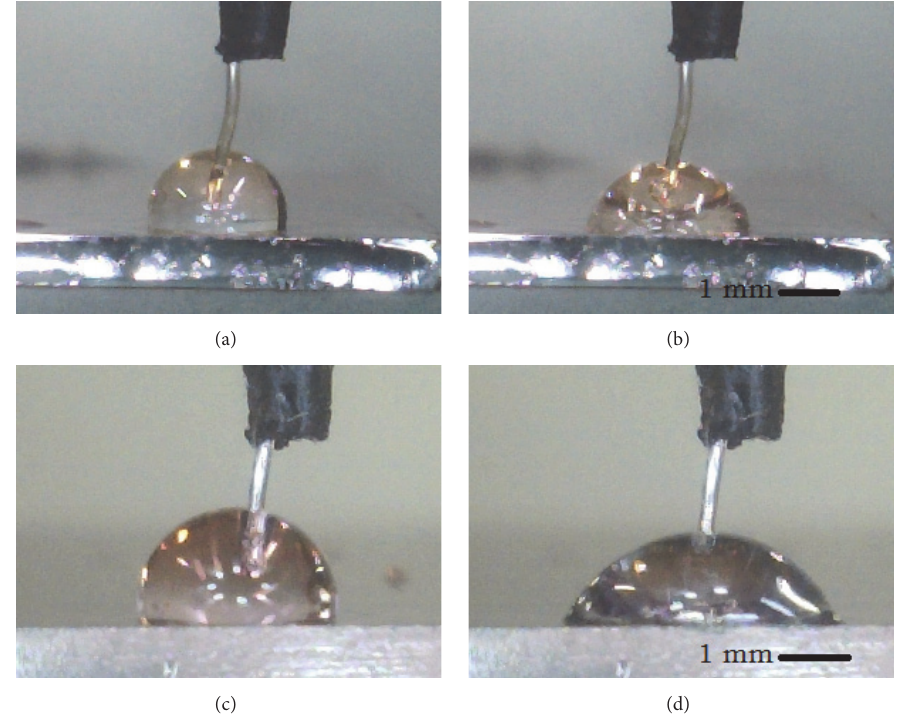
Figure 4: Change in droplet curvature and base diameter due to electrowetting actuation for deionized water: (a) at 0V; (b) at 10V. For a 0.5 𝜇 m nanofluid droplet, (c) a smaller contact angle at 0V and (d) an enhanced electrowetting response at 10V are observed.